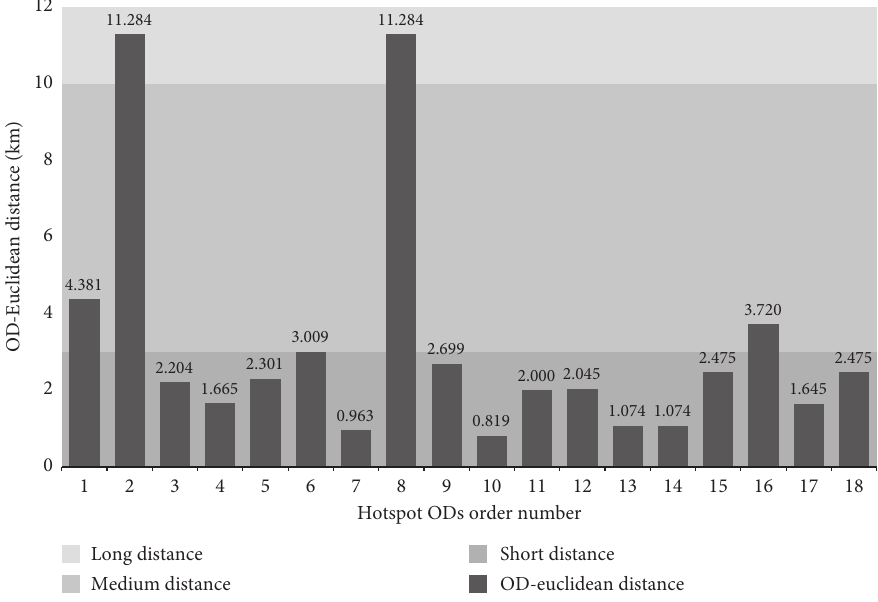
Figure 6: Euclidean distance distribution of hotspot ODs.